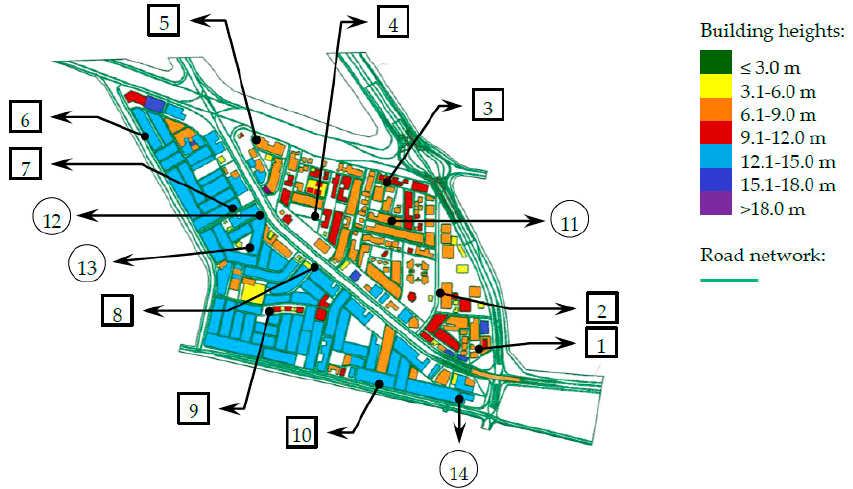
Figure 4. The study model showing building heights and road network, and noise measurement locations in Al-Fayha District (Squares: free field measurements at 1.5 m above ground; Circles: façade measurements).